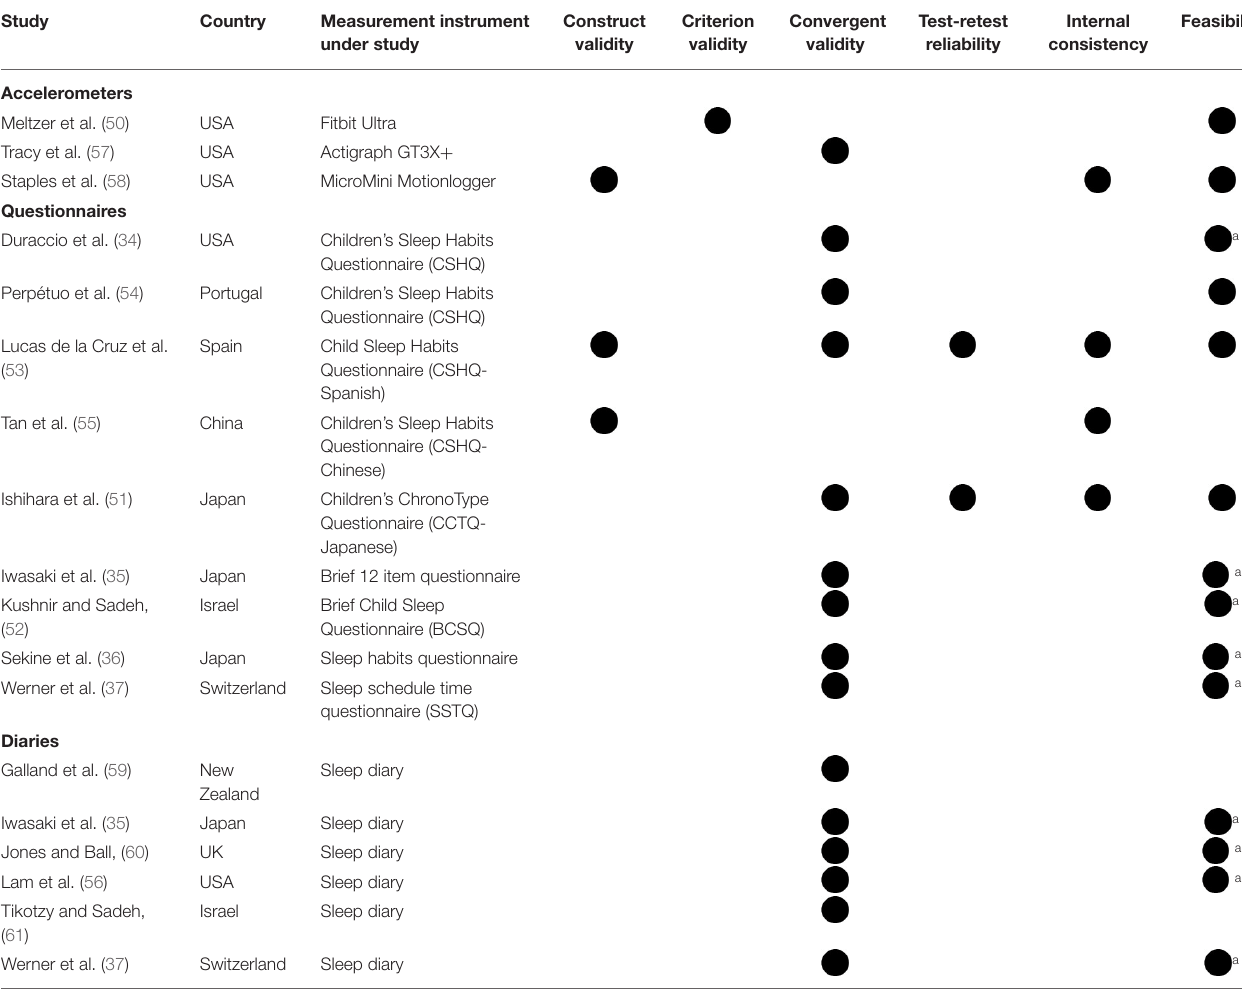
TABLE 3 | Overview of measurement properties examined in each